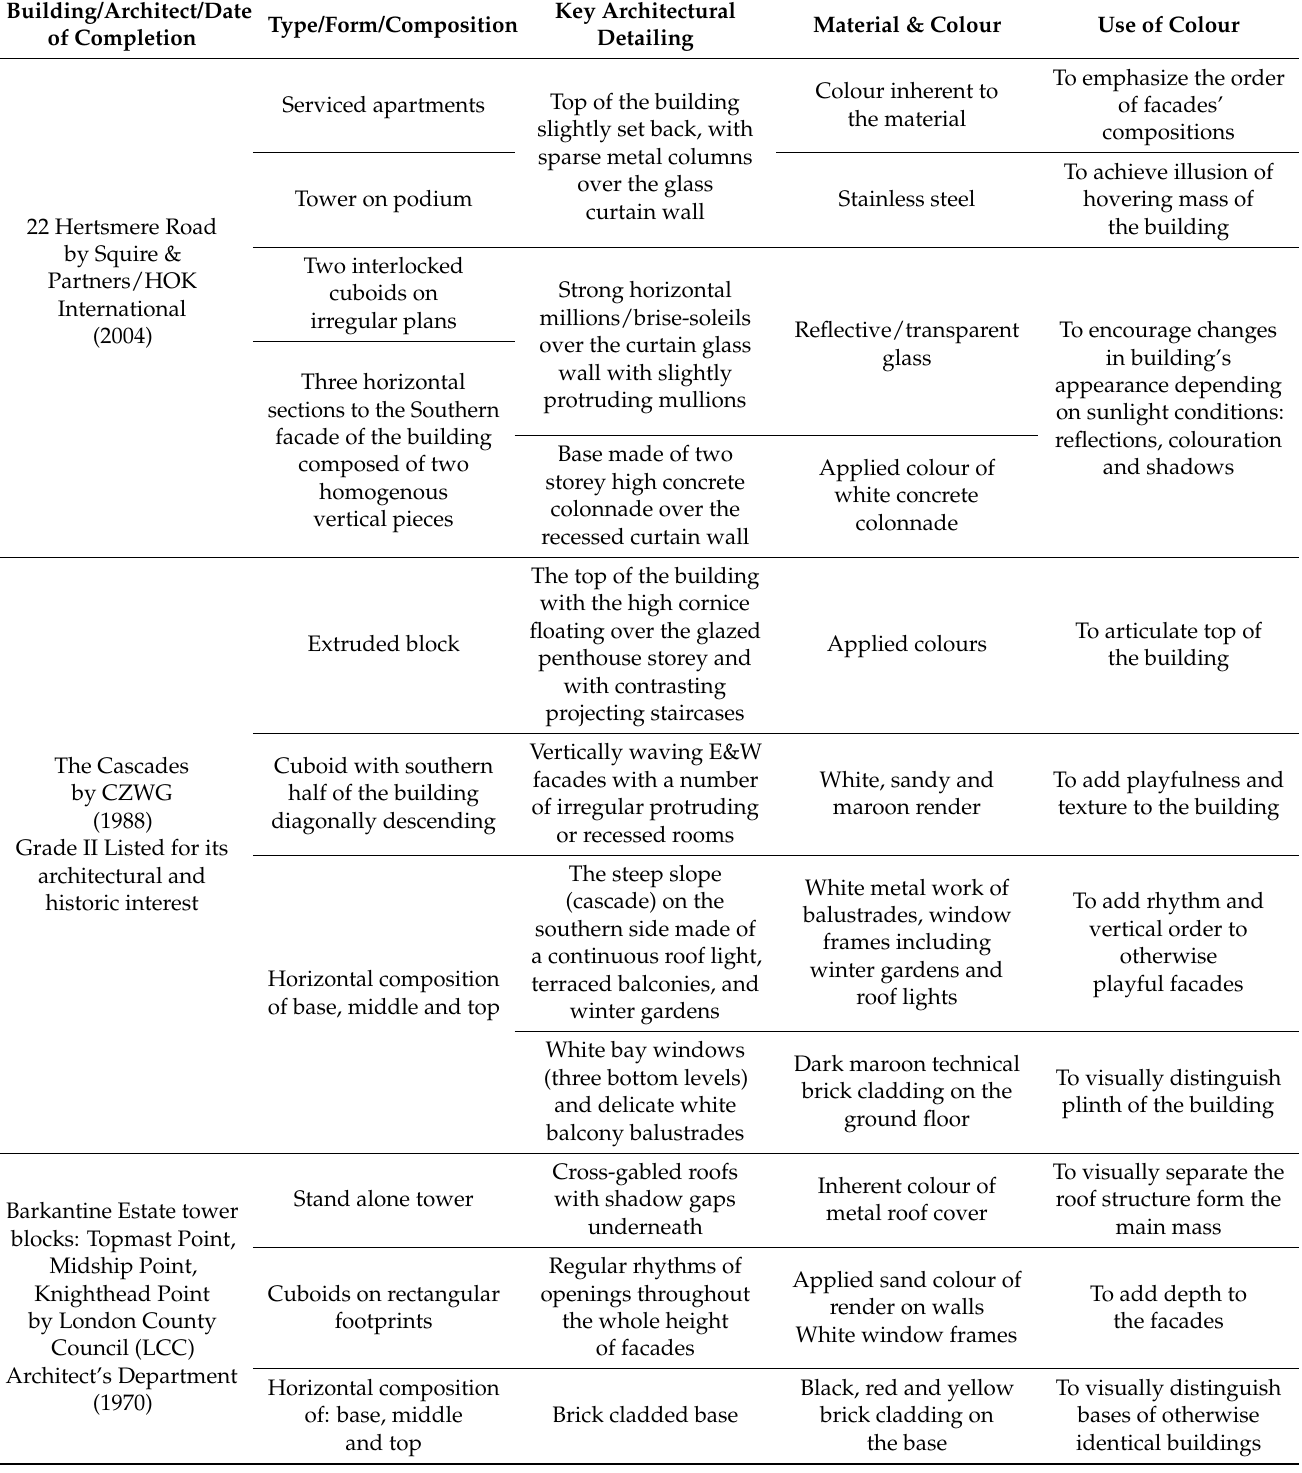
Table A2. Use of colour in tall residential buildings from the first phase of the regeneration on the Isle of